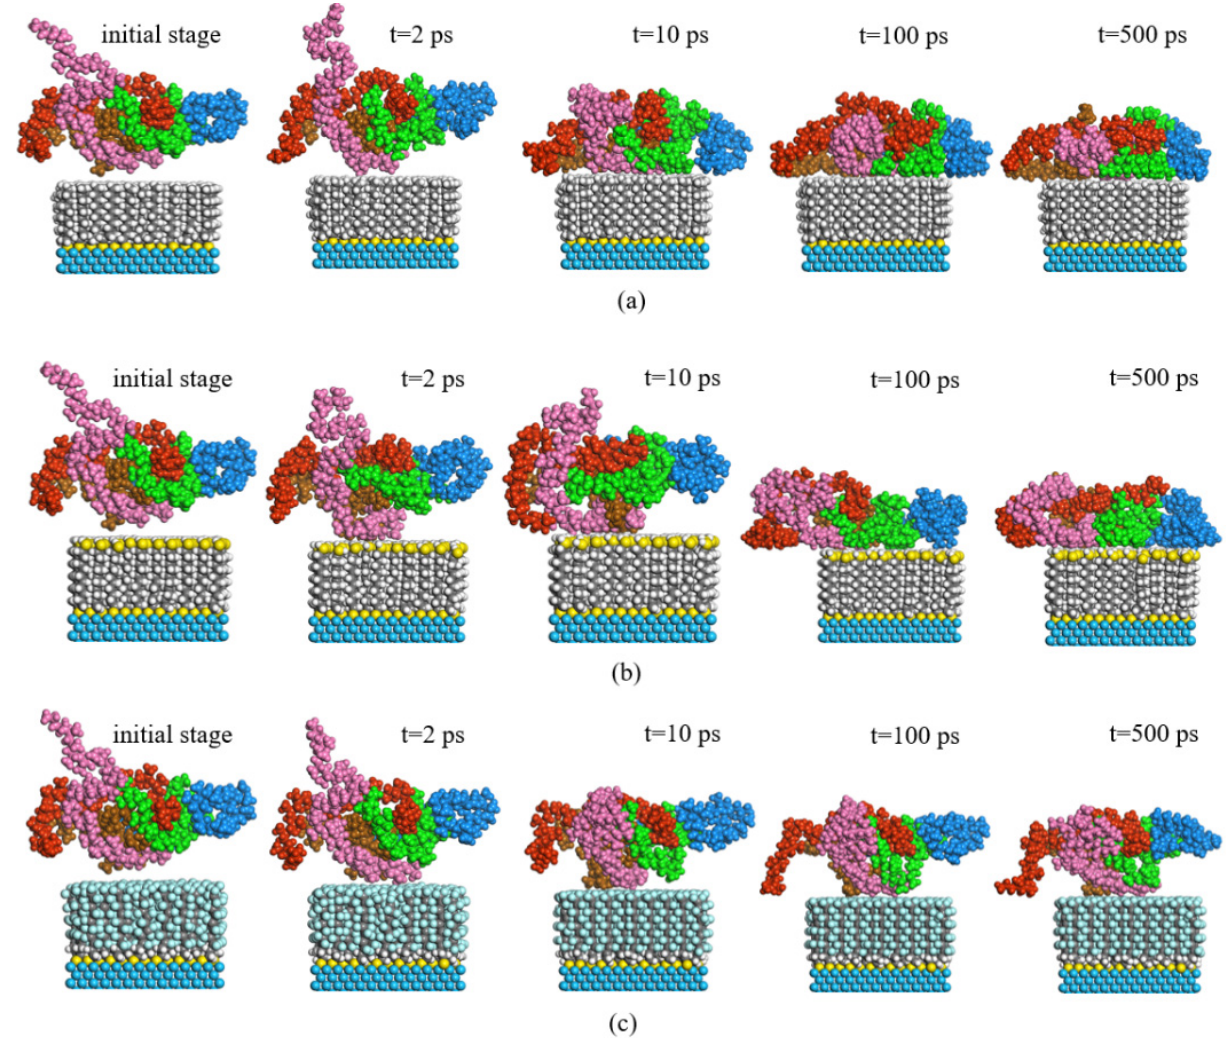
Figure 10. Morphological evolution of PP in C (2 × 2) arrangement: ( a ) DT, ( b ) DDT and ( c ) PFDT.